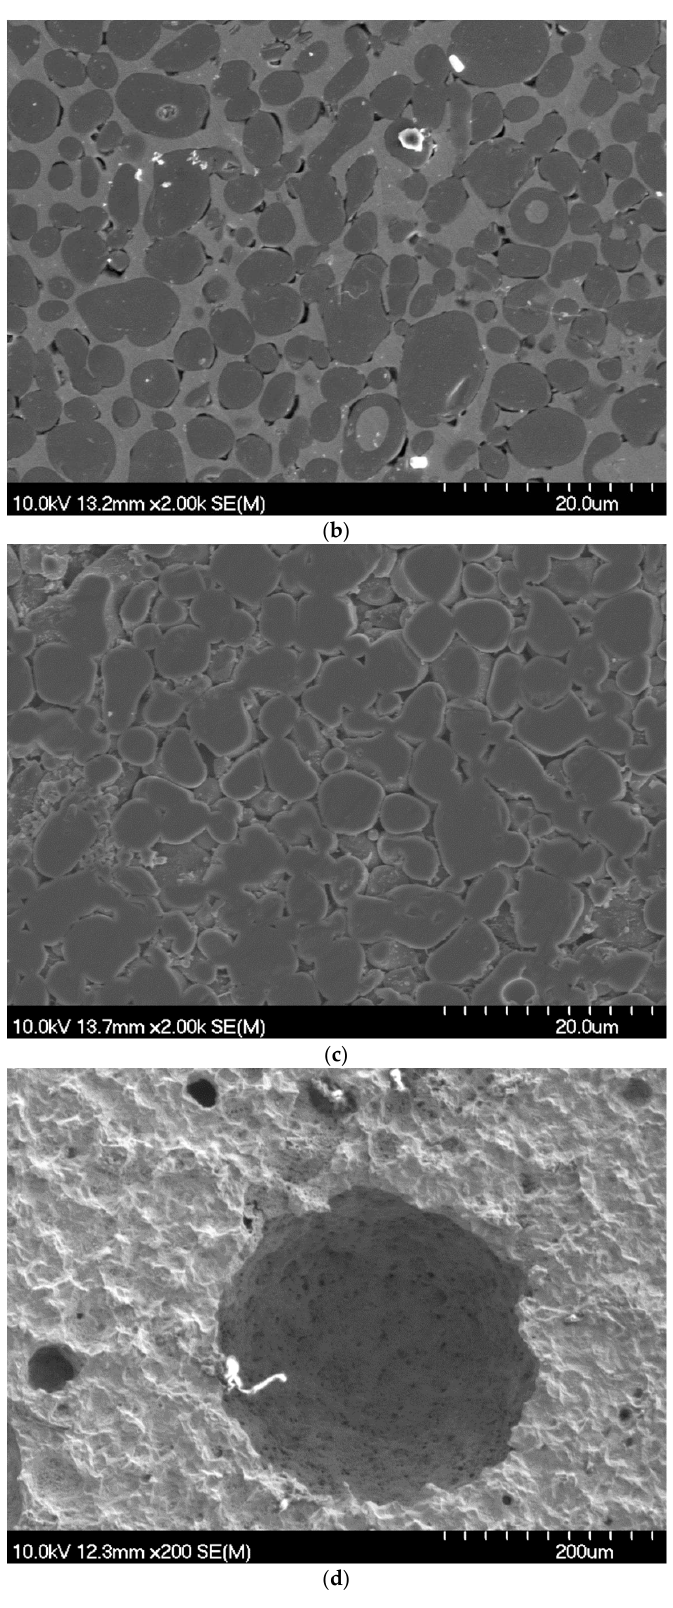
Figure 8. Representative SEM images of the corroded surfaces of selected TiC–stainless steel cermets and single metallic phase, 410 L steel following cyclic polarisation testing: ( a ) 20 vol. % 304 L; ( b ) 20 vol. % 316 L; ( c ) 20 vol. % 410 L; and ( d ) “pure” 410 L stainless steel.